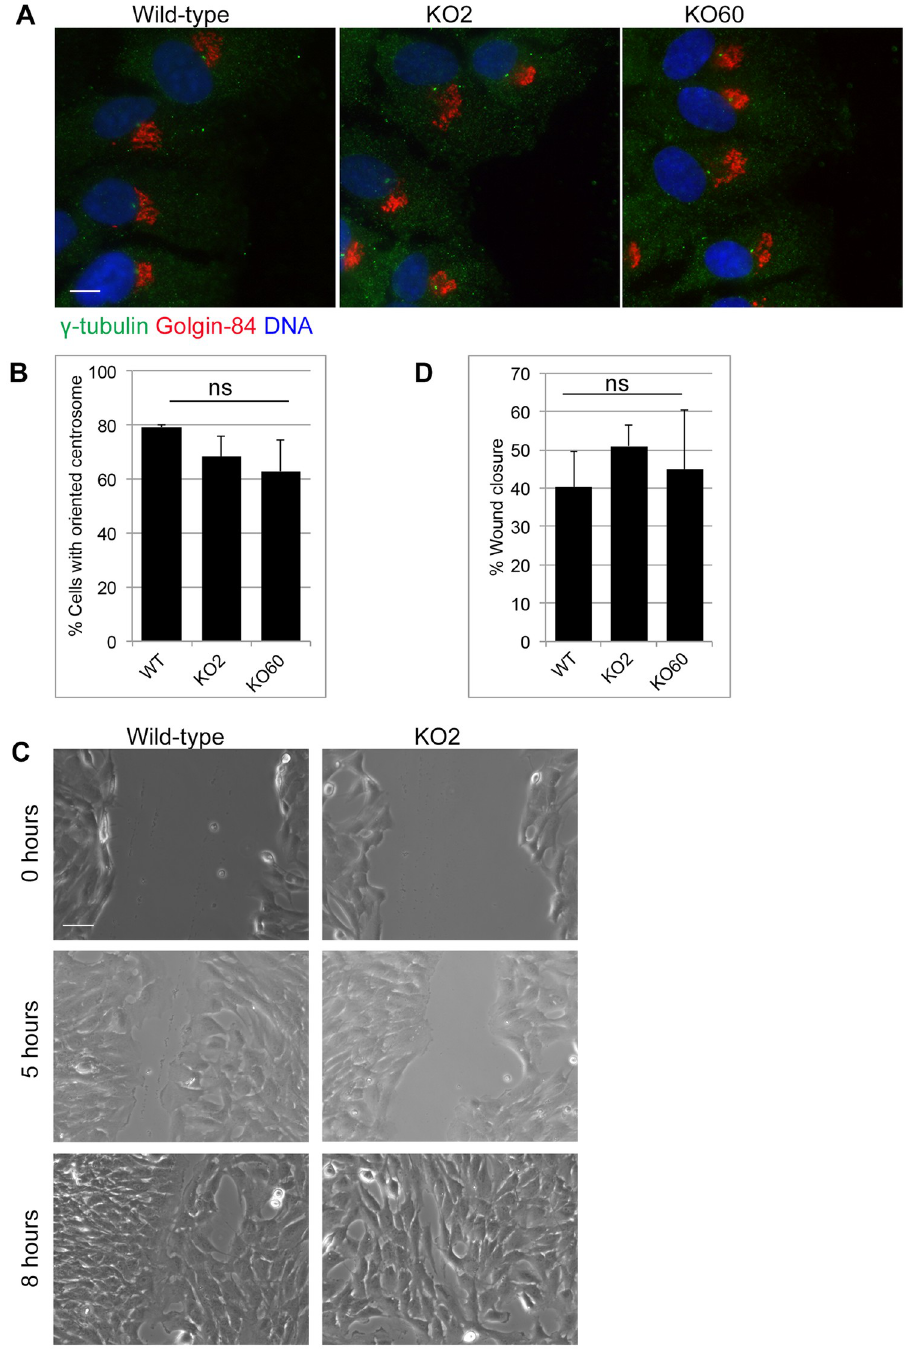
Fig 6. Golgi-centrosome proximity is dispensable for polarization and directional cell migration. A scratch wound was introduced into confluent cell monolayers using a micropipet tip. A . Wounded monolayers were fixed 5 hours post wounding and stained for γ -tubulin and Golgin-84. Scale 10 μ m. B . Quantification of the cell polarization assay of Fig 6A. A centrosome was considered oriented if it was found in front of the nucleus, facing the wound. The data is from three independent experiments, with at least 100 cells analyzed per condition. ns = not statistically significant. C . Wounds were imaged at 0, 5 and 8 hours after wounding. Representative images for wild-type and KO2 cells are shown. Scale 50 μ m. D . Quantification of wound width for wild-type, KO2 and KO60 monolayers at 0 hours and 5 hours. The data is from three independent experiments, with at least ten measurements at different positions along the wound for each